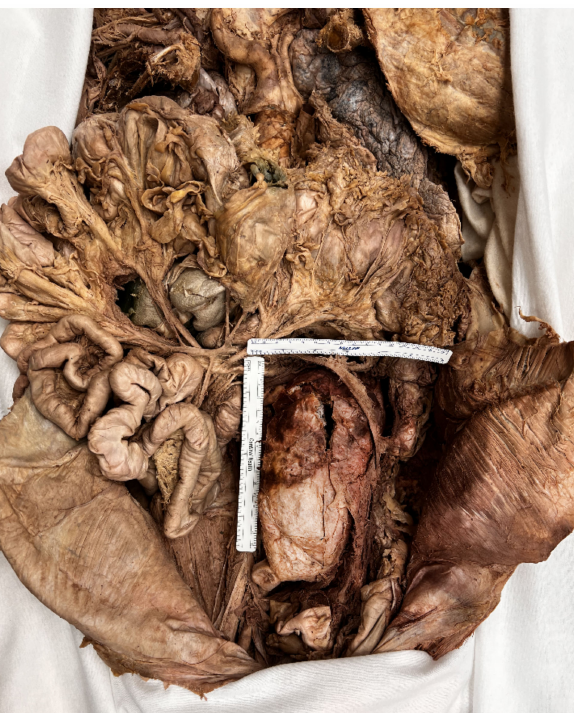
Figure 2. Infrarenal AAA situated above the aortic bifurcation. Large areas of plaque are observable in Figure 3b and marked with an arrow. White